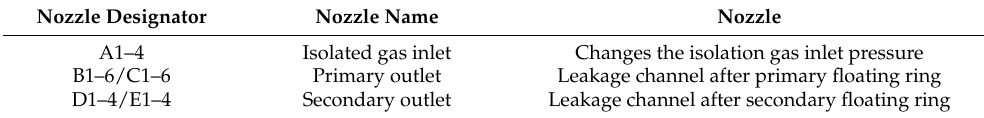
Table 3. Interpretation of nozzle.